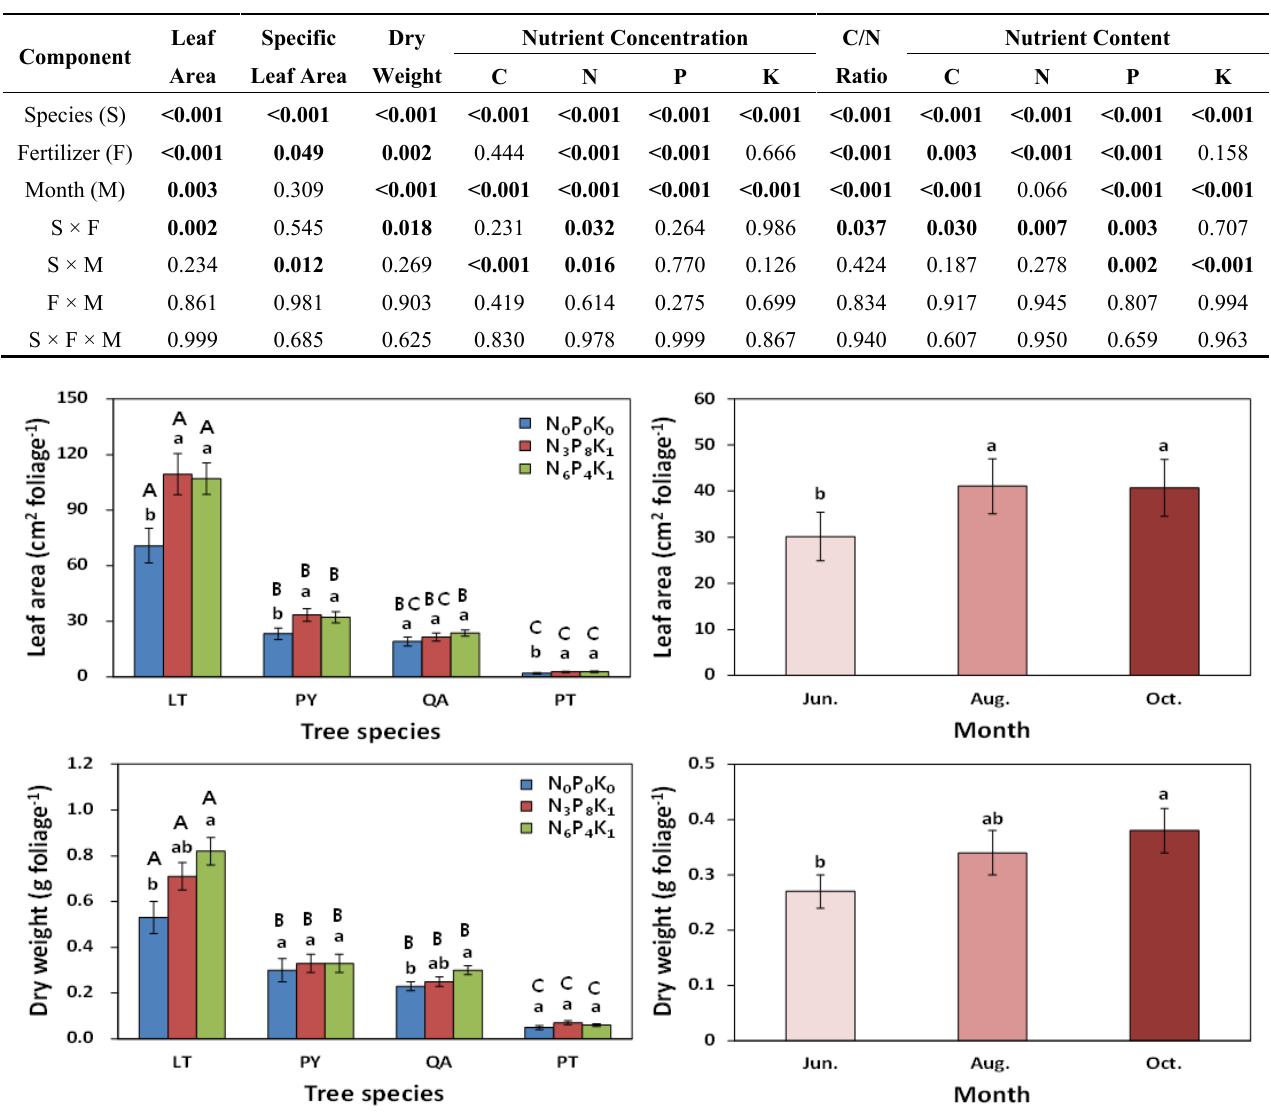
Figure 3. Leaf area and dry weight of foliage by tree species and sampling month in a fire-disturbed urban forest (mean ± standard error). Treatment means with the same lower case letter among fertilizer or sampling month treatments and treatment means with the same upper case letter among tree species are not significantly different at p <